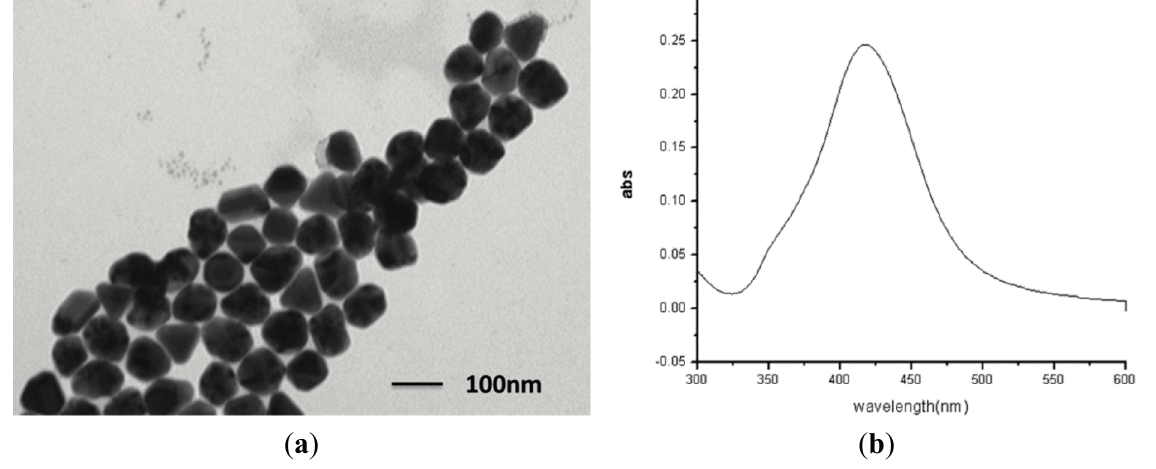
Figure 2. ( a ) Transmission electron microscopy (TEM) images of silver colloidal nanoparticles; ( b ) UV-Vis absorption spectra of silver colloid.